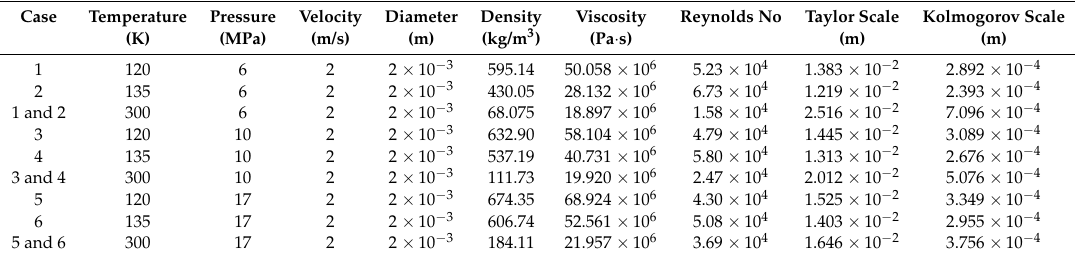
Table 3. Table of turbulence length scales associated with all the cases in Table 2.